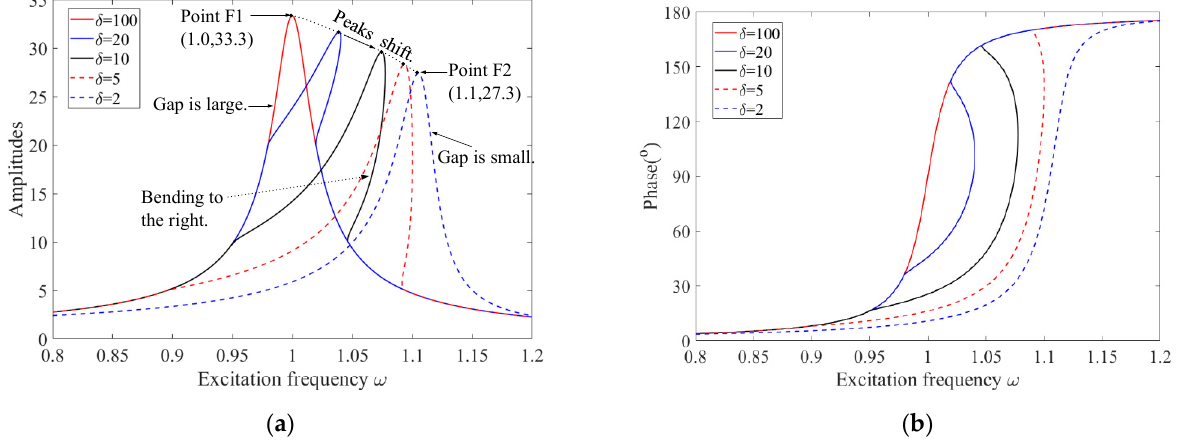
Figure 3. Amplitude–frequency characteristics and phase–frequency characteristics of Dof-1 in the system with different gaps: ( a ) amplitude–frequency characteristics; ( b ) phase–frequency characteristics.